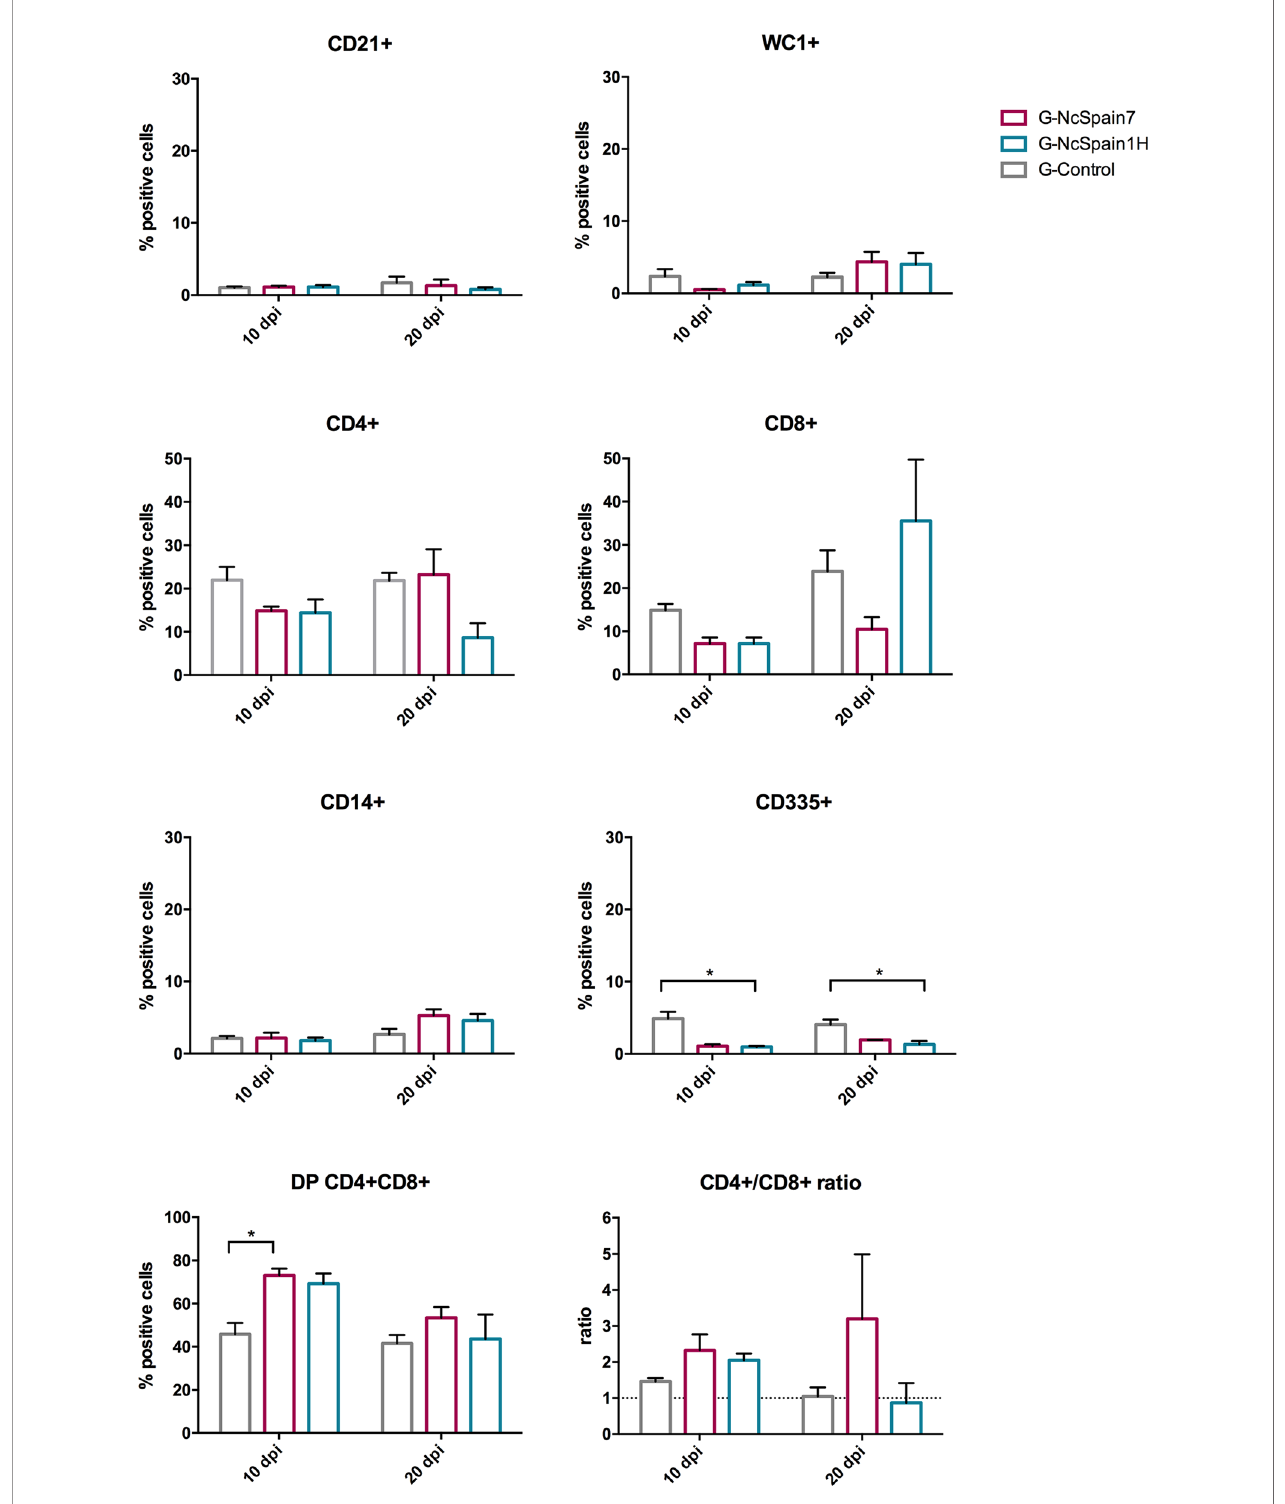
FIGURE 5 | Immune cell populations in the thymus of foetuses from Nc-Spain7 and Nc-Spain1H infected heifers at 10 and 20 dpi. Graphs indicate the relative percentage of cells positive for CD21, WC1, CD4, CD8, CD14 and CD335 surface markers, double positive (DP) CD4+CD8+ cells and CD4+/CD8+ ratio, in the population of immune cells obtained from the thymus of foetuses from uninfected heifers (G-Control) and heifers challenged with Nc-Spain7 (G-NcSpain7) and Nc-Spain1H (G-NcSpain1H) tachyzoites culled at 10 or 20 dpi. The results are represented as the mean+SD. Asterisks indicate signi fi cant differences. * P <0.05.